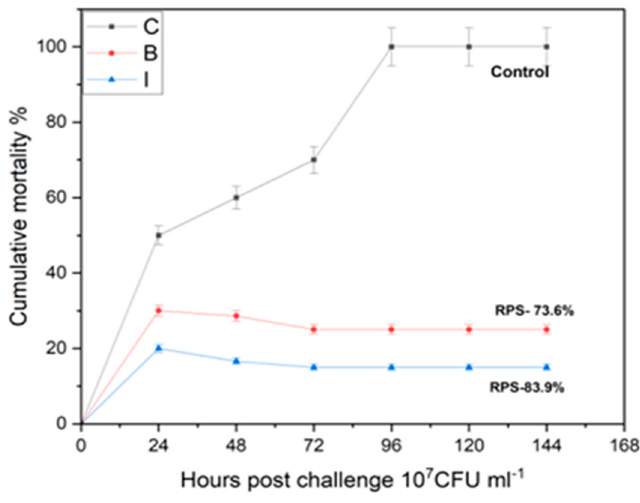
Figure 12. Cumulative mortality index (CMI) of all three groups (Control, Immersion and Bio-encapsulated) postchallenge.